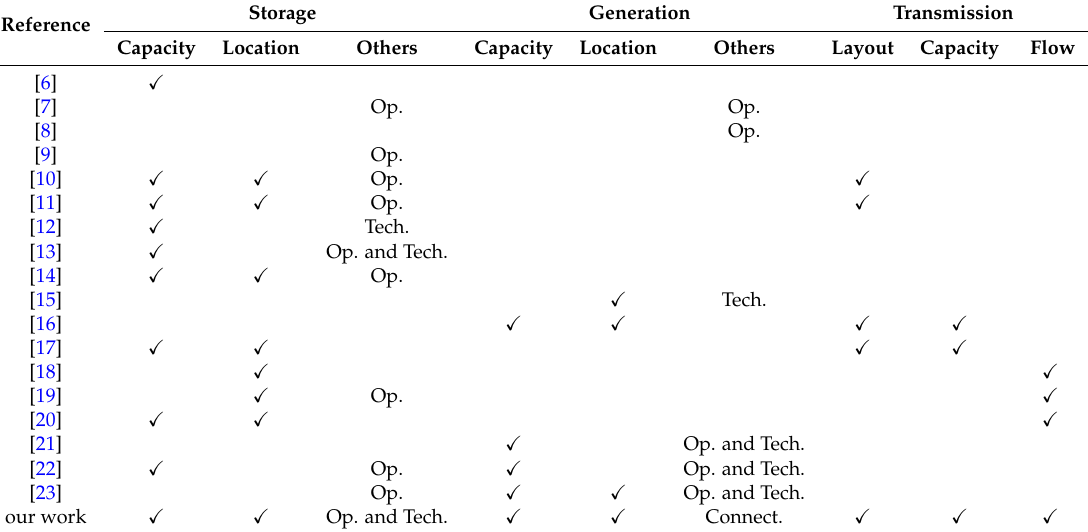
Table 1. Summary of the literature related to energy systems’ planning incorporating renewable and conventional generation, transmission and storage sizing and design. Op., operational profiles; Tech., technological